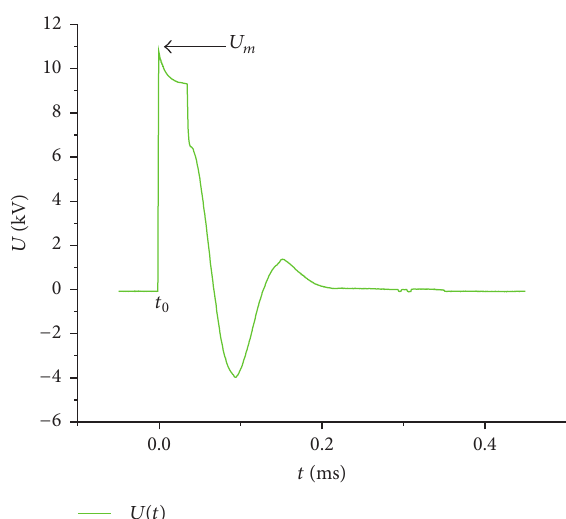
Figure 7: Time history curve of the discharge voltage 𝑈(𝑡) .